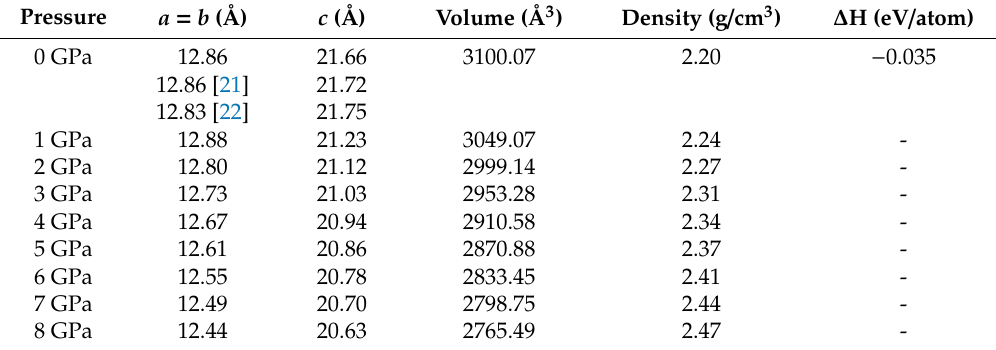
Figure 1. Crystal structure of Mg 23 Al 30 at ground state. Table 1. The calculated parameters of Mg 23 Al 30 under different pressures (pressure range: 1–8 GPa).